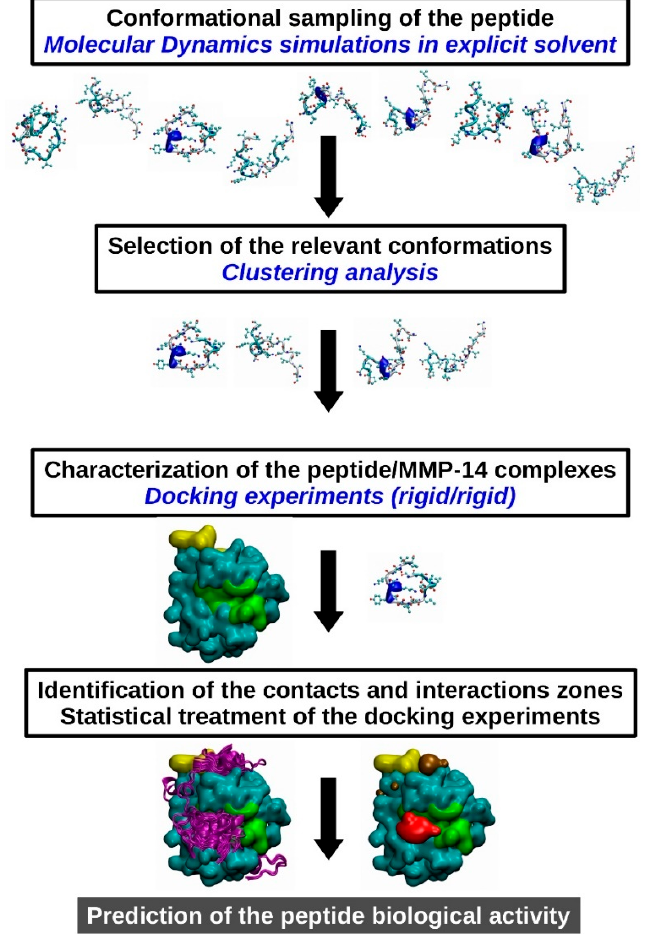
Figure 2. Scheme of the strategy used to decipher and predict the interaction between SLRP-derived peptides and the catalytic domain of MMP-14. The workflow designed for the present study is a 4-step process: (i) the intrinsic flexibility of the peptides is explored through classical MD simulations, (ii) the most relevant conformations are selected using clustering analysis, (iii) peptide/MMP-14 complexes are determined using a rigid/rigid docking software, and finally (iv) contacts and interactions areas are statistically